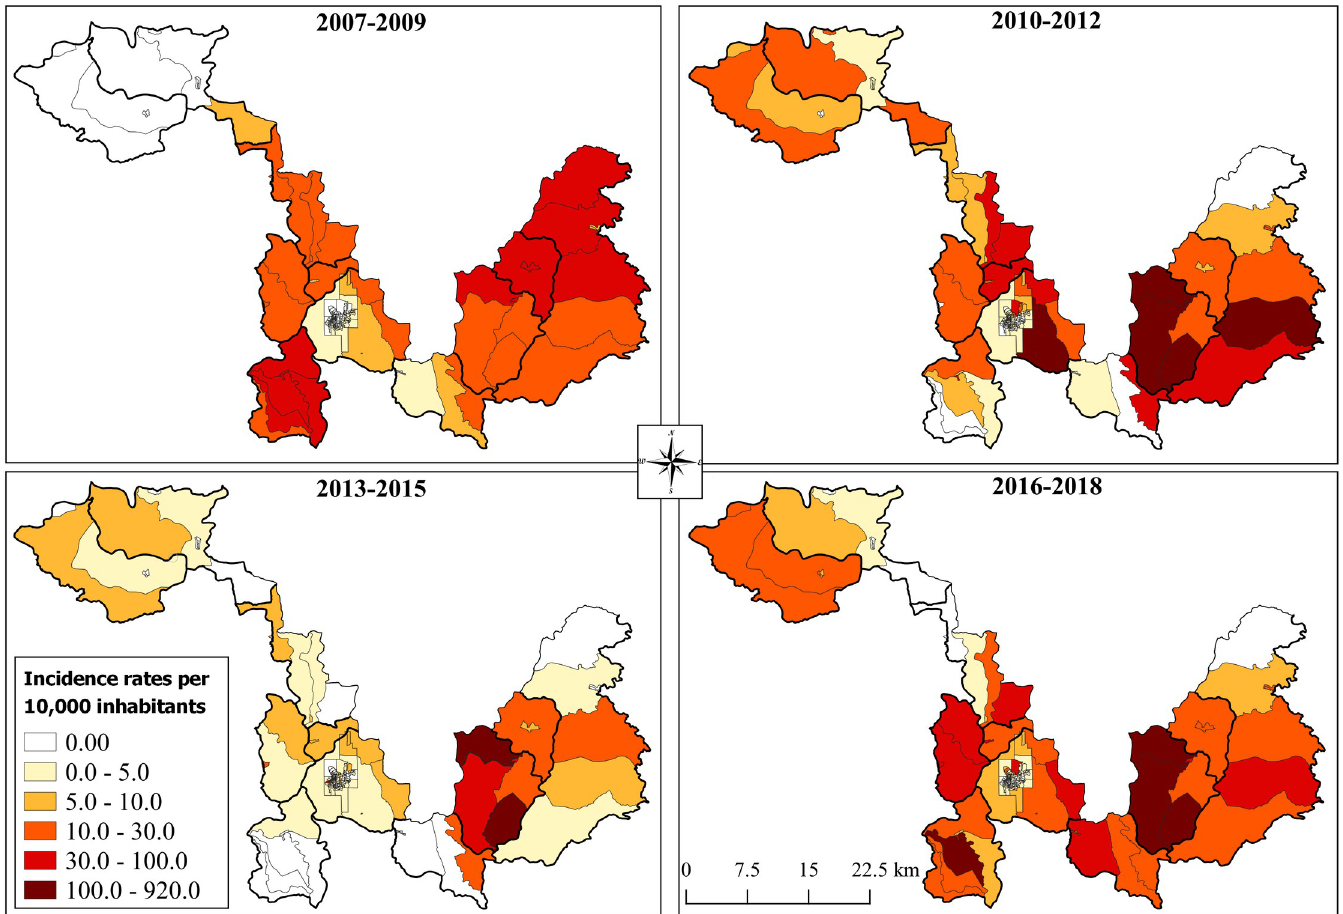
Fig 3. Smoothed Accumulated Incidence, per 10,000 inhabitants, of ATL cases belonging to the municipality of Caratinga (www.ibge.gov.br).